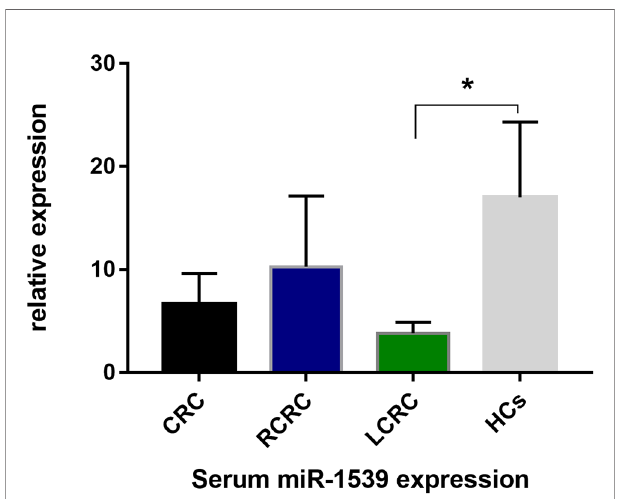
FIGURE 3 | Serum-based miR-1539 expression levels between CRC, LCRC, RCRC, and HCs groups. The expression of serum miR-1539 decreased in LCRC ( p = 0.031). Y-axis represents the miR-1539 relative expression by 2 - △ Ct method. Mean with 95%CI are indicated in the bars. CRC, colorectal cancer; HCs, healthy controls; RCRC, right-sided colorectal cancer; LCRC, left-sided colorectal cancer. *p < 0.05.